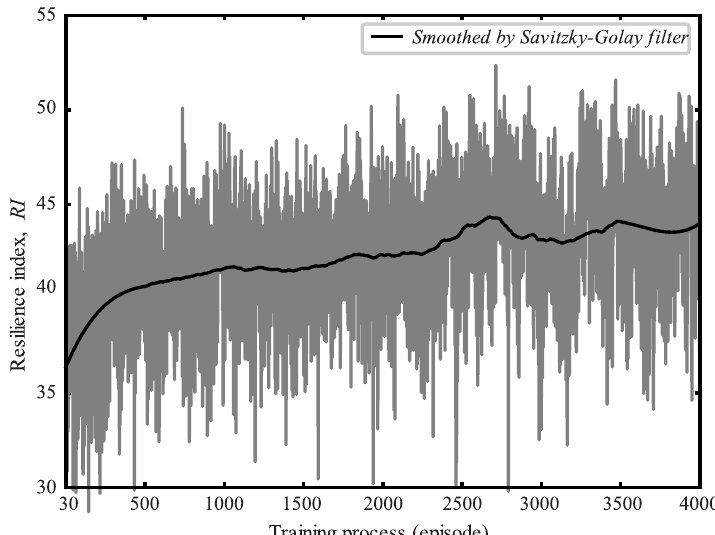
Fig 14. The variations of system resilience index during the training process of the GCN-DRL model under the assumption that all road sections are inundated by flood